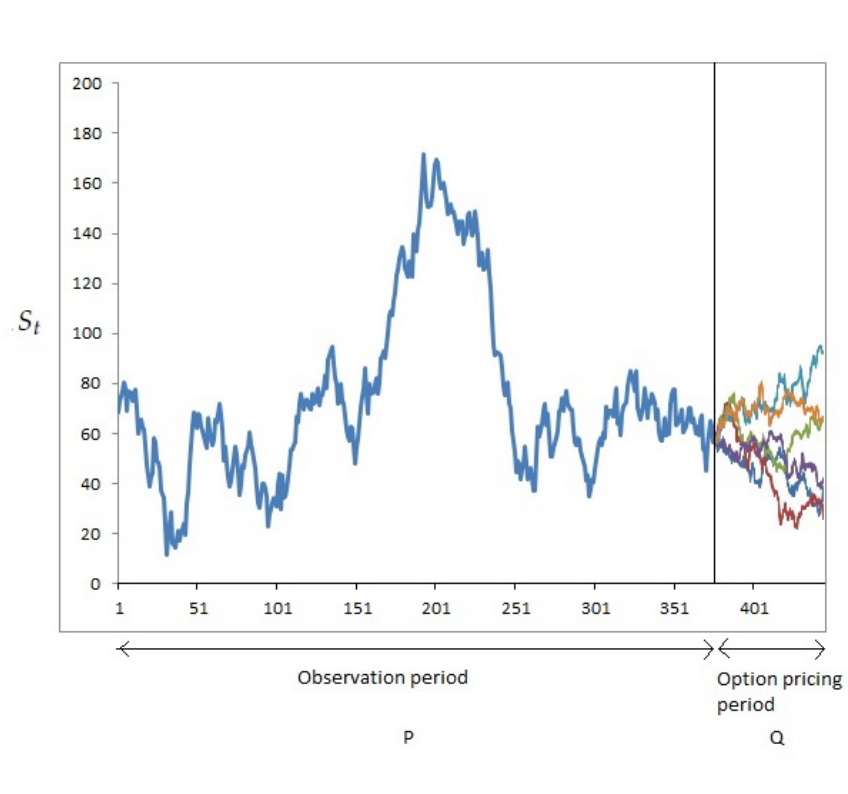
Figure 1. Historical asset price movement and simulated asset